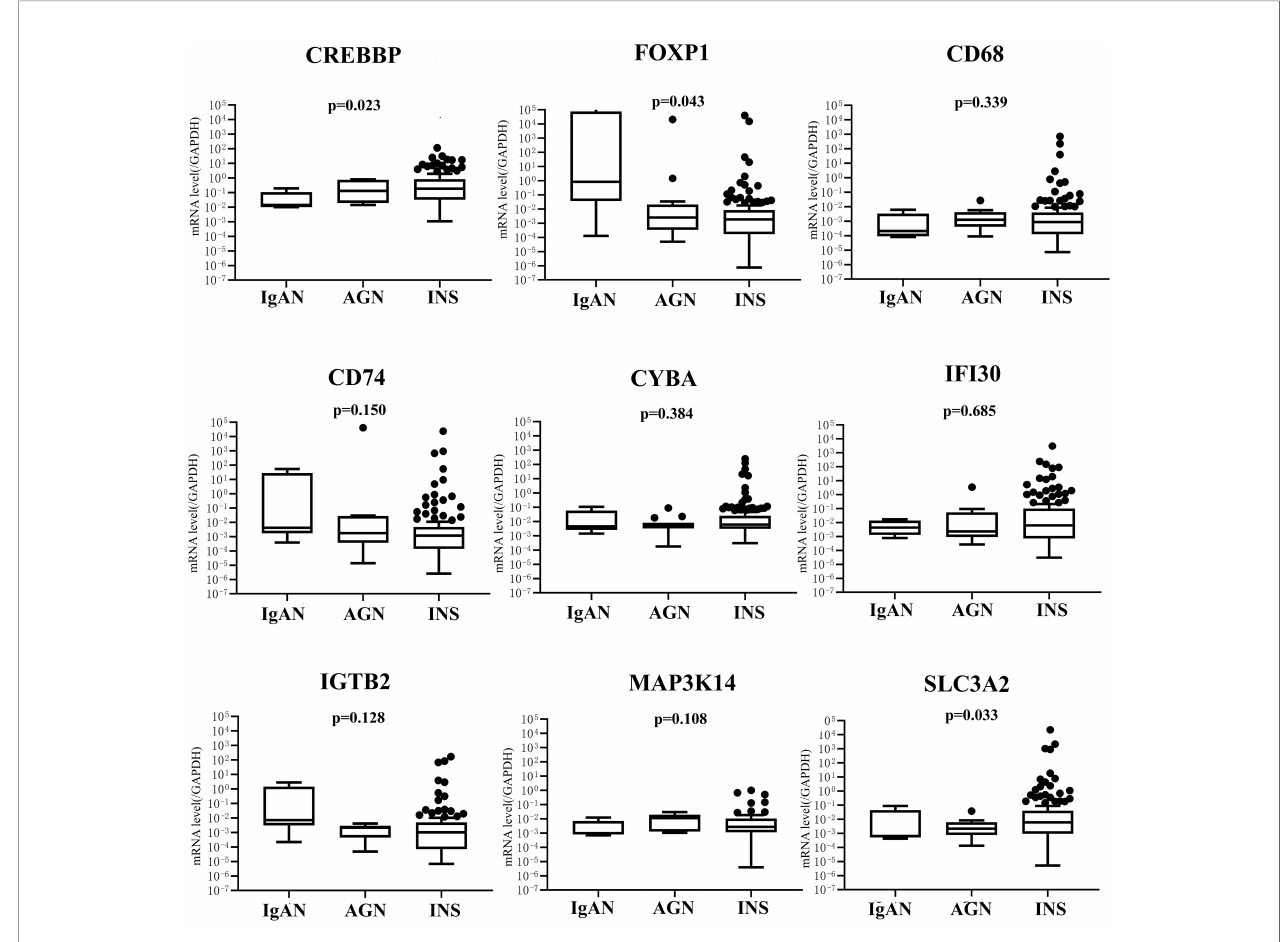
FIGURE 2 | mRNA expression of nine genes in IgAN ( n = 15), GN ( n = 6), and INS ( n = 129) groups. IgAN, IgA nephropathy; AGN, acute glomerulonephritis; INS, idiopathic nephrotic